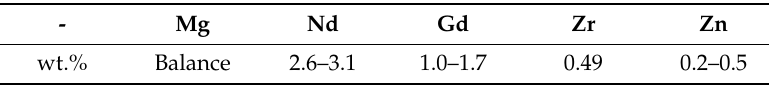
Table 1. Chemical composition of (wt.%) of El 21 Mg-alloy billets.